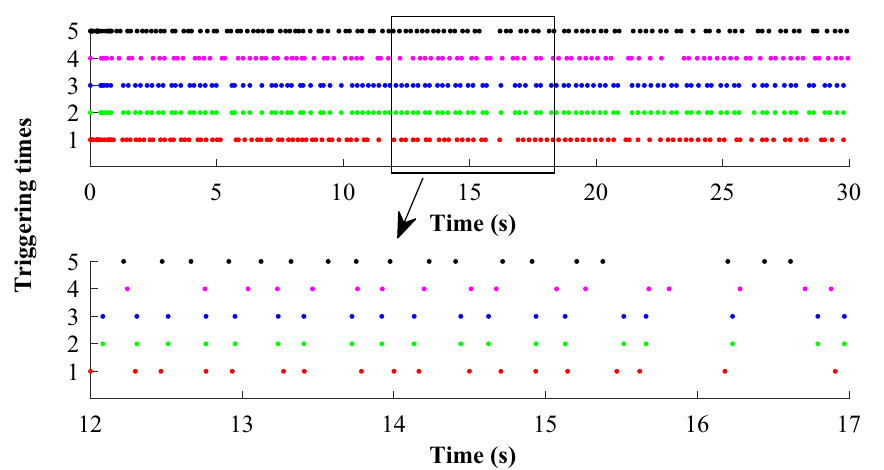
Figure 7. Simulation results: The triggering times for different agents (The numbers 1, 2, 3, 4, and 5 on the y-axis represent agent1, 2, 3, 4, and 5, respectively).